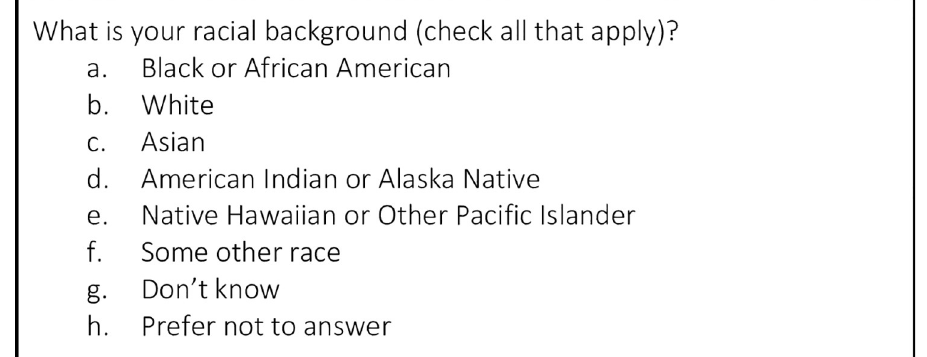
Fig 2. Racial background questions in the WISDOM trial.